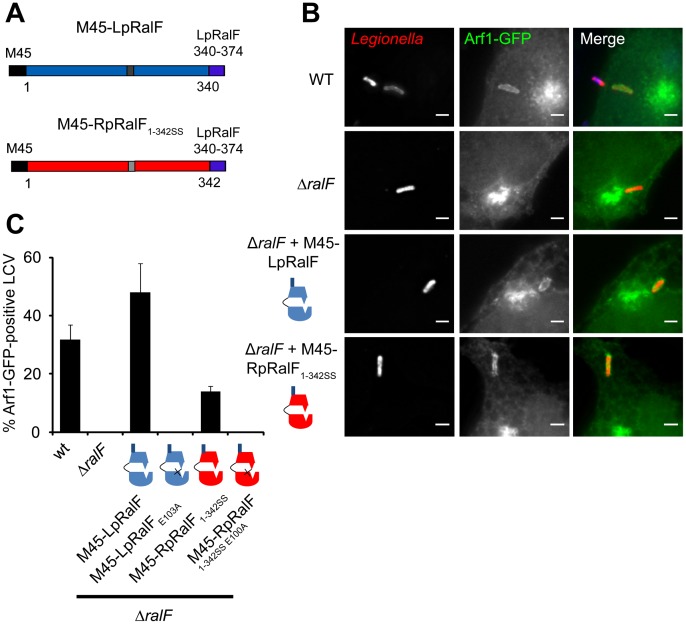
RpRalF inefficiently restores Arf1 recruitment to vacuoles containing Legionella ΔralF.
A) Representation of the constructs used in the complementation experiment. B) HEK293 cells stably expressing Arf1-GFP were infected with different strains of L. pneumophila (wt, ΔralF mutant and ΔralF mutant complemented with M45-LpRalF, M45-LpRalFE103A, M45-RpRalF1–342SS or M45-RpRalF1–342SSE100A,). Cells were fixed 1 h post-infection, extracellular bacteria were stained in blue, and total bacteria in red. Bar = 1 µm. C) Quantification of Arf1-GFP recruitment to the LCV by the indicated L. pneumophila strains. Represented is the average of 3 experiments where 50 vacuoles were counted. Standard deviations are indicated.